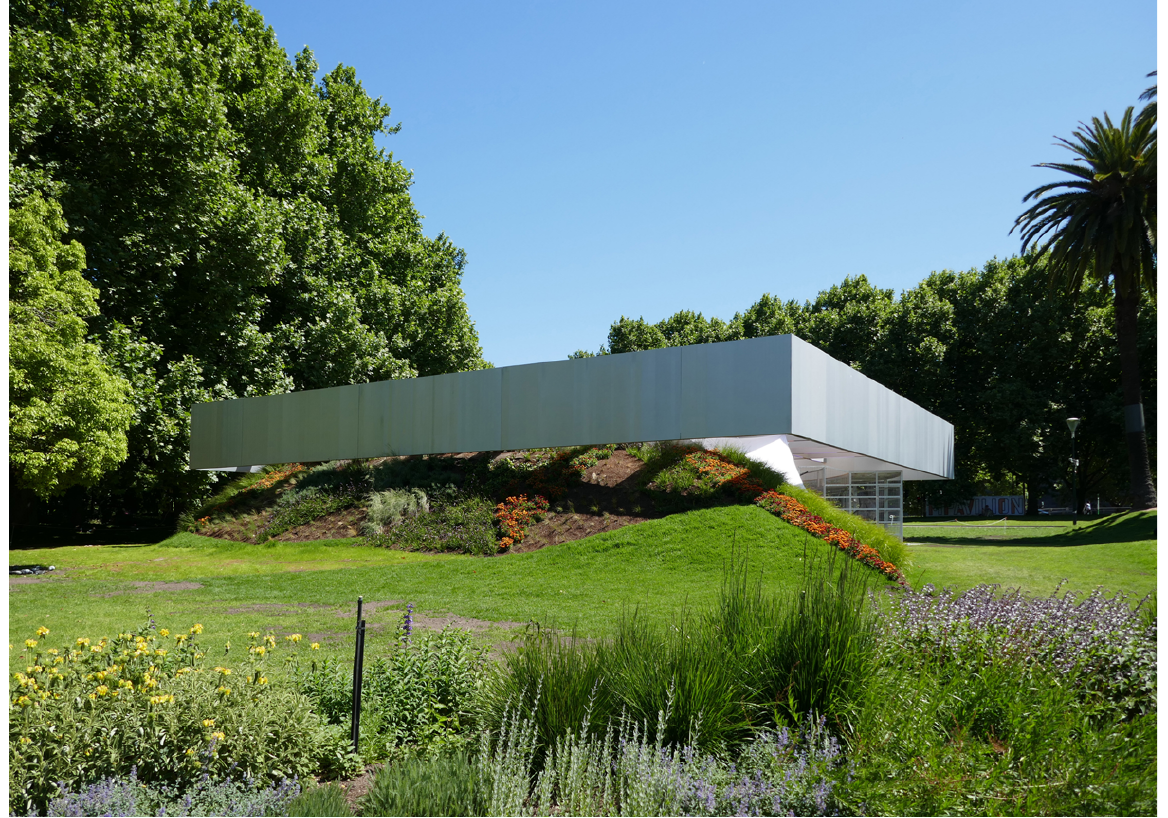
FIG. 2 Rem Koolhaas and David Gianotten / OMA, 2017 MPavilion, Melbourne. Source: Photograph by Ashley Paine,